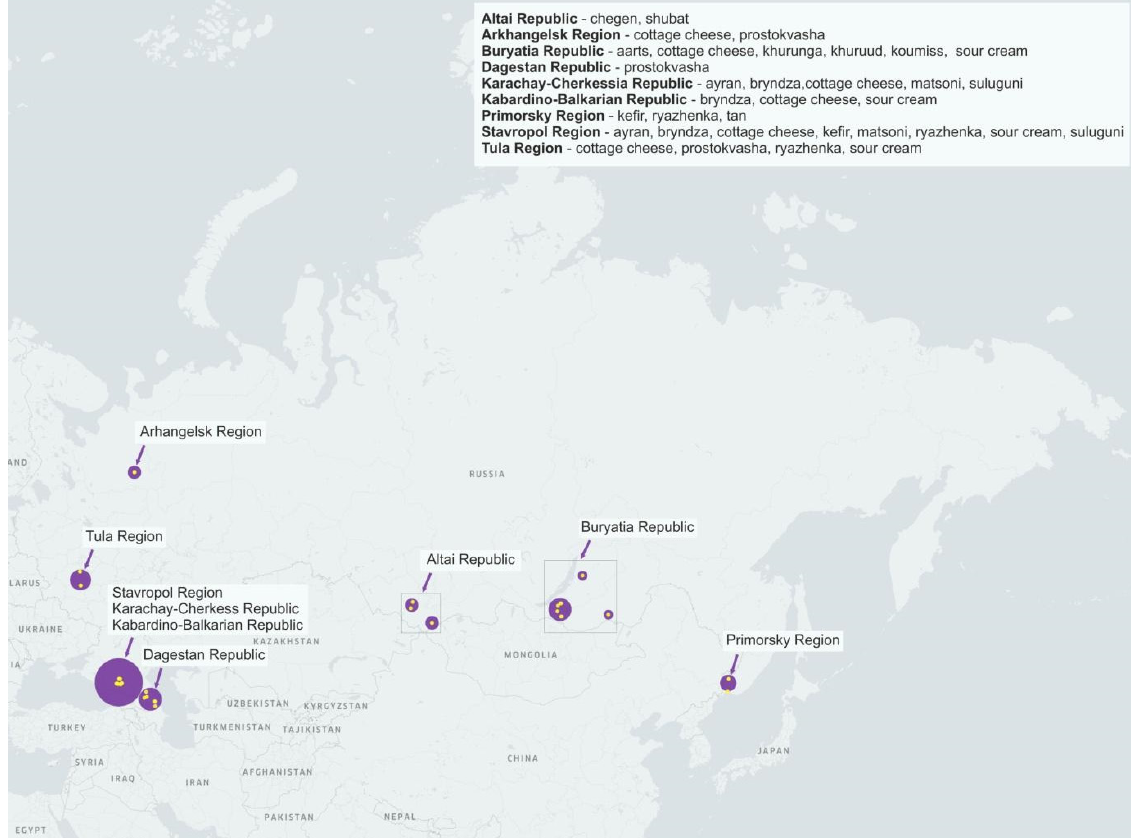
Figure 1. Geographic location of sampling sites. Table 1. Samples of fermented milk products, their location and pH.